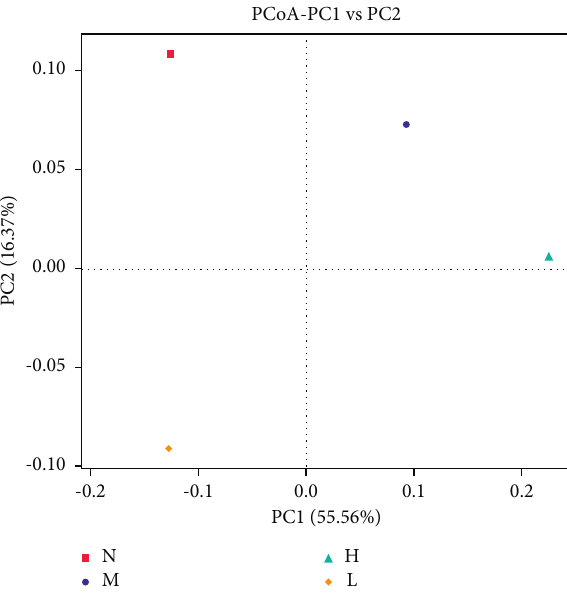
Figure 11: PCoA of each group.